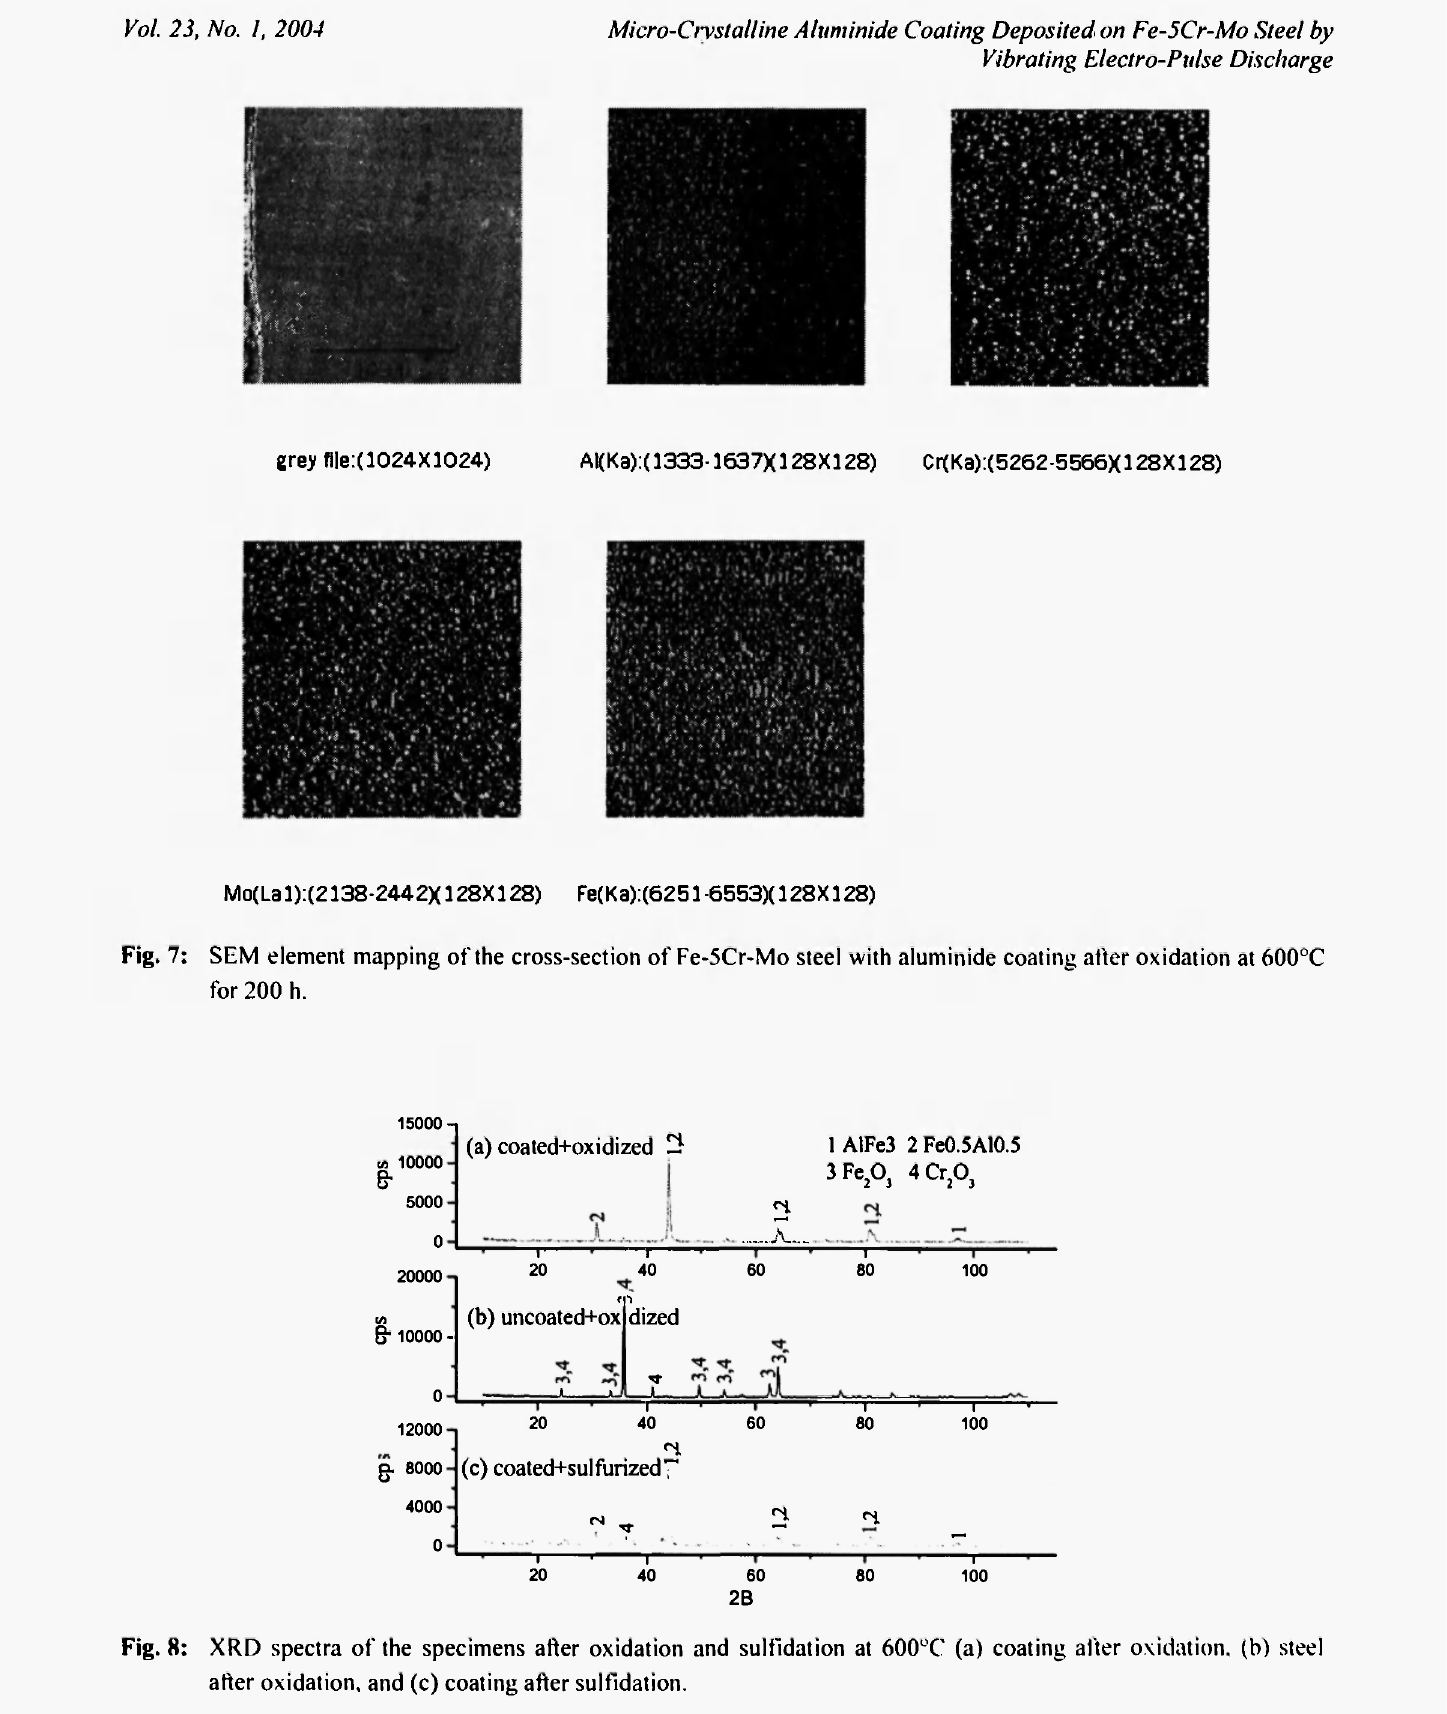
XRD spectra of the specimens after oxidation and sulfidation at 600°C (a) coating after oxidation, (b) steel after oxidation, and (c) coating after